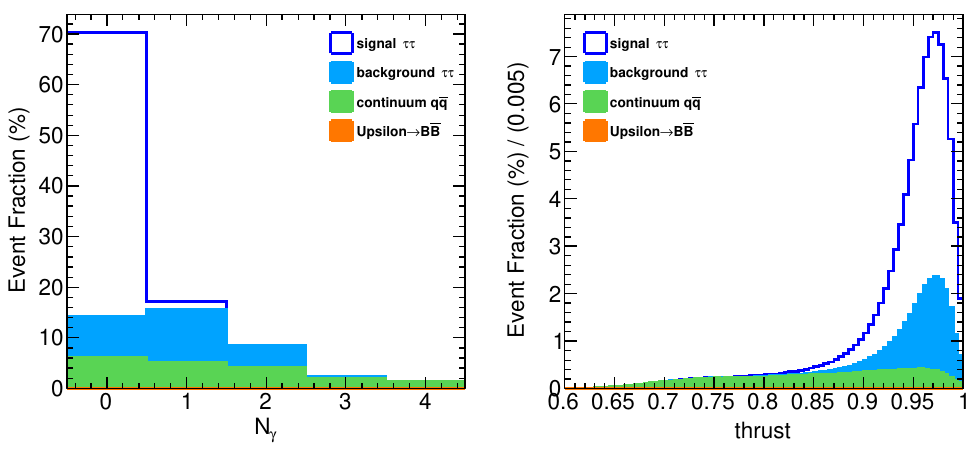
Figure 1 . The N (cid:13) and thrust distributions after the tau pair selection. Di(cid:11)erent simulation components are